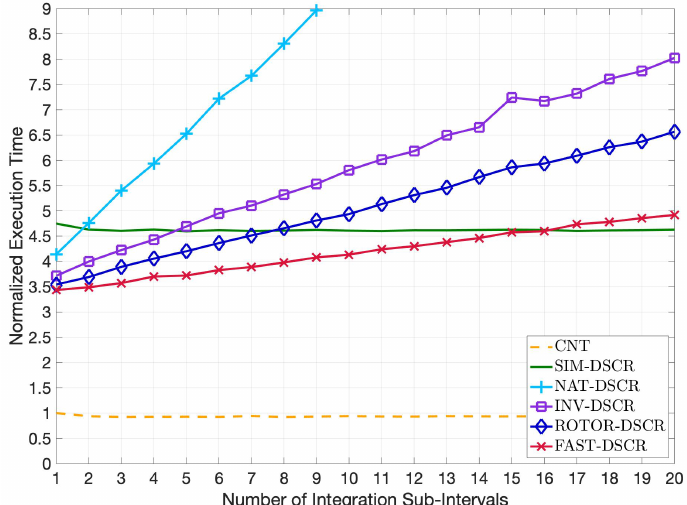
Figure 10. Execution time comparison increasing the discrete sub-interval integration number. CNT and SIMULINK-DSCR do not depend on the number of sub-intervals. Time is normalized to the CNT execution